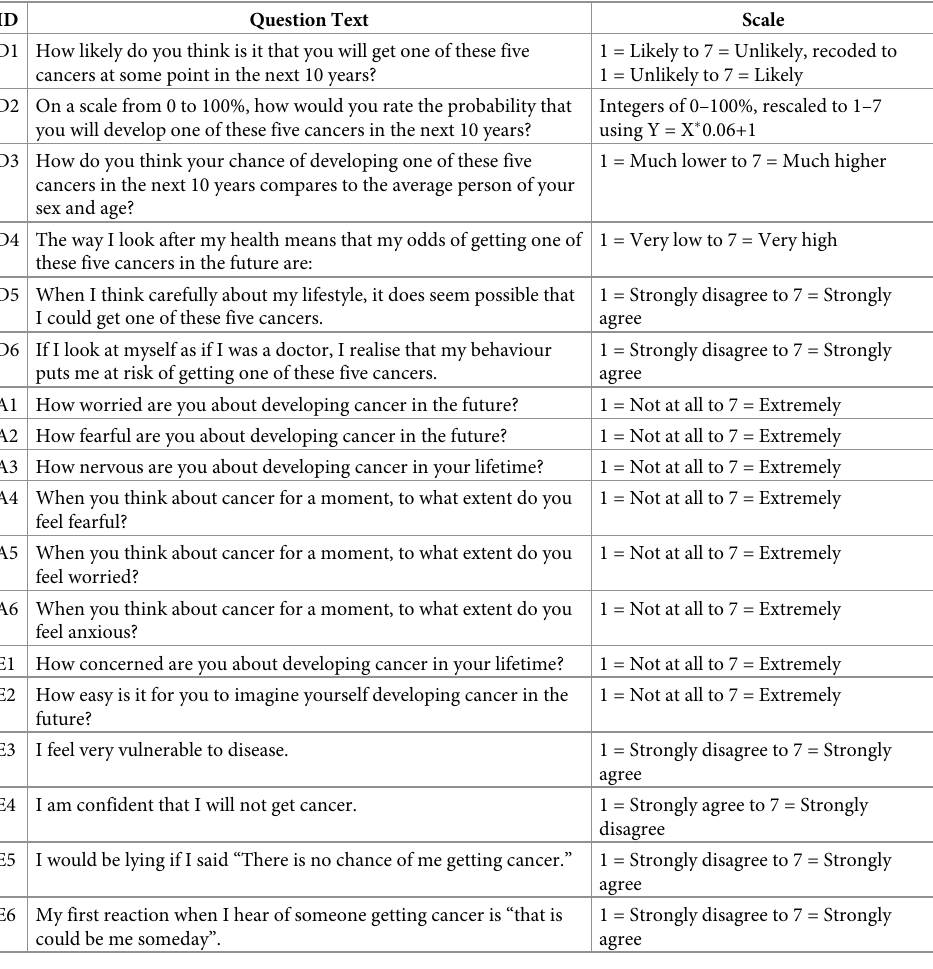
Table 1. Measures of risk